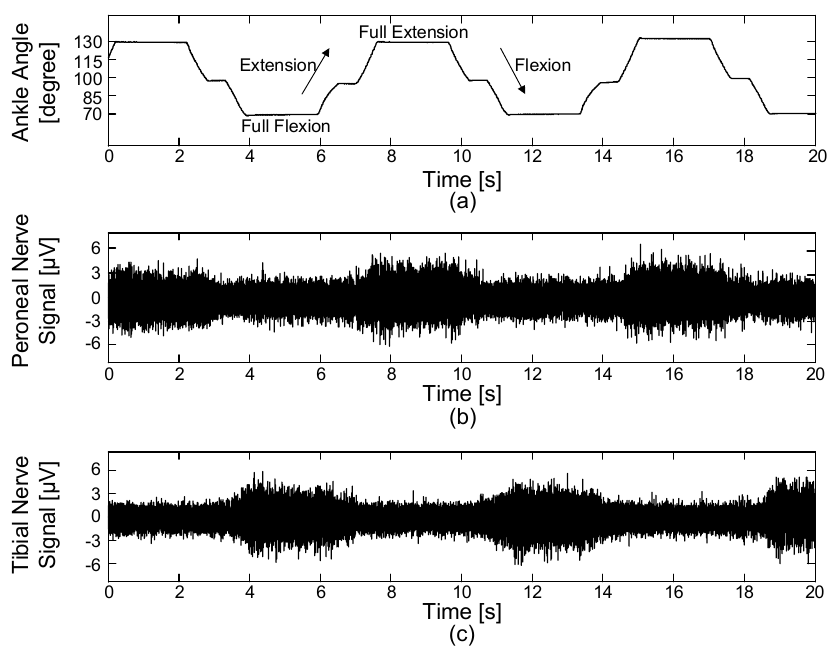
Figure 17. Acquired joint angle and ENG signals during the passive movements of the rabbit’s ankle: ( a ) joint angle, ( b ) ENG signals from the peroneal nerve and ( c ) ENG signals from the tibial nerve.